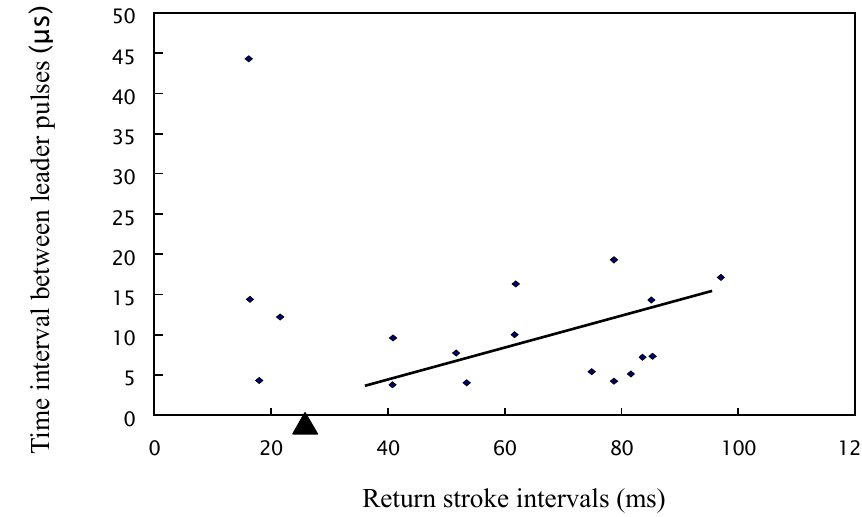
Fig. 7. Distribution of time interval between successive leader pulses for different stroke